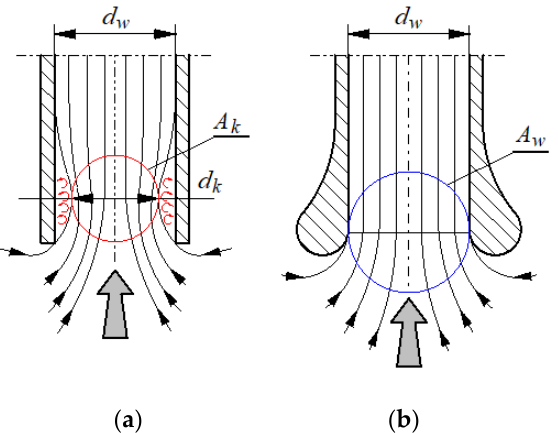
Figure 28. Air inflow into the cylindrical tube: ( a ) with sharp inlet opening edges and ( b ) with streamlined inlet opening shape.